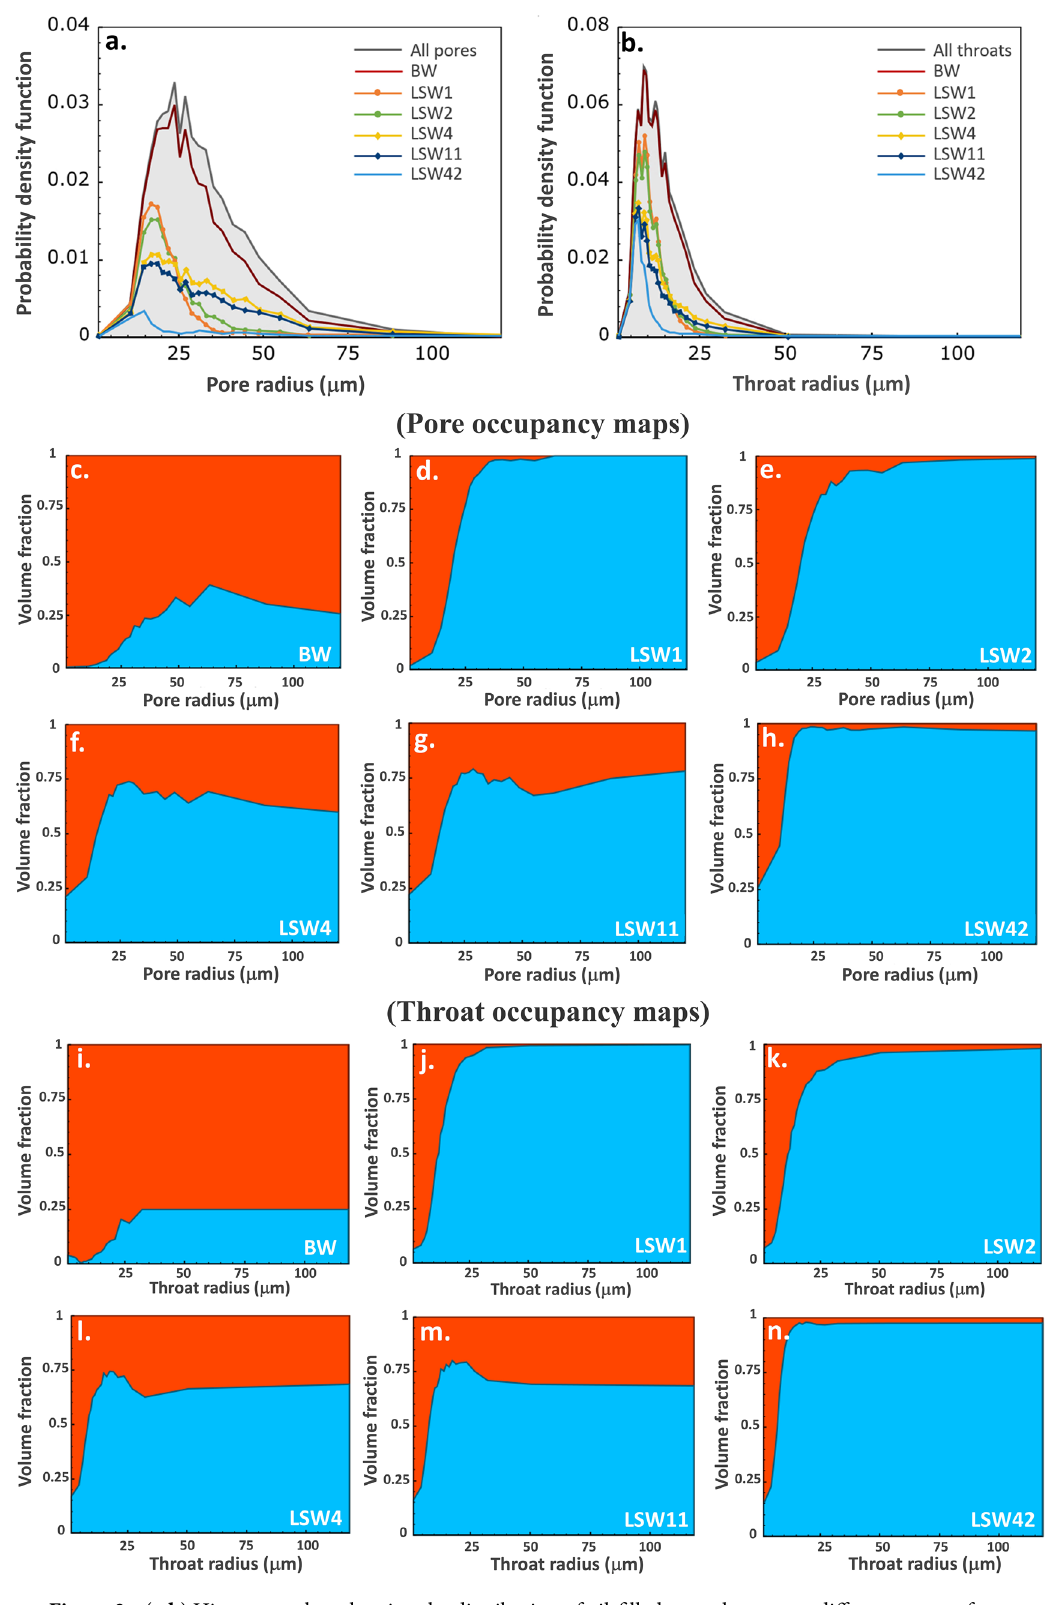
Figure 3. ( a,b ) Histogram plots showing the distribution of oil-filled pore elements at different stages of waterflooding. ( c–n ) Pore and throat occupancy maps showing the volume fraction of pores and throats of different radii occupied by oil (red) and brine